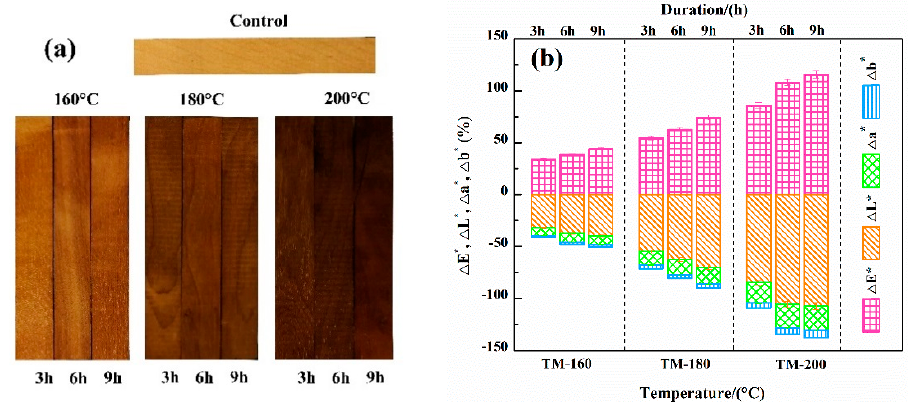
Figure 8. Surface color ( a ) and color parameters ( b ) of the control and thermally-modified woods.